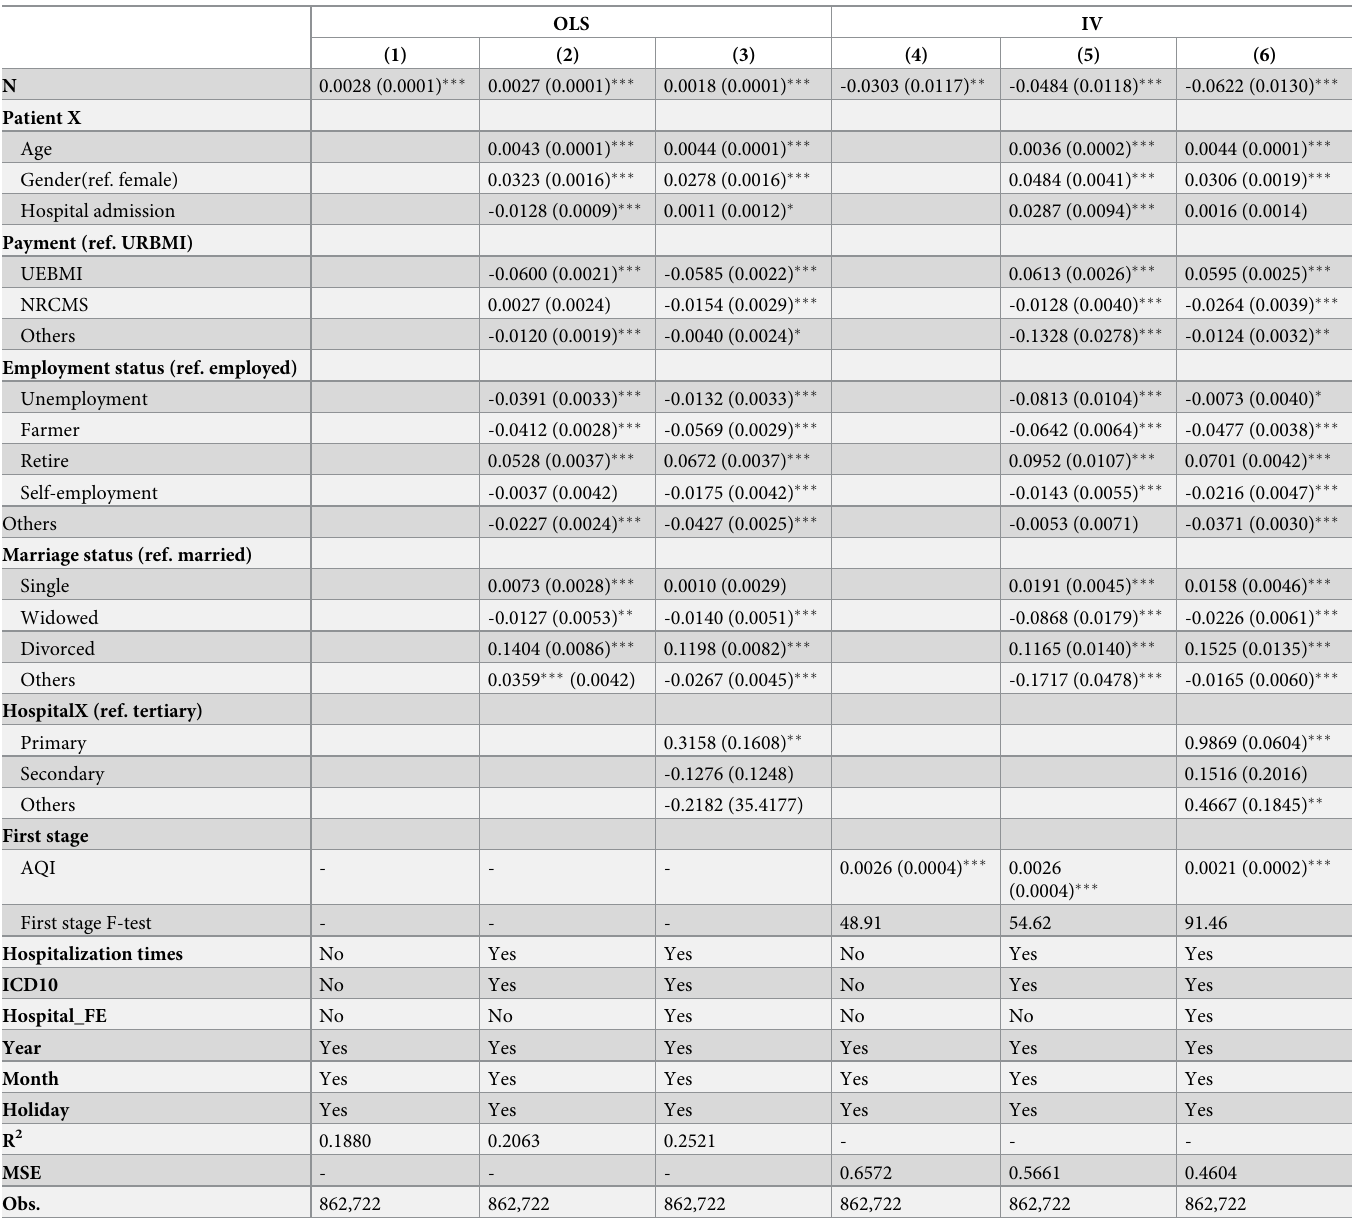
Table 3. Regression results of log length of